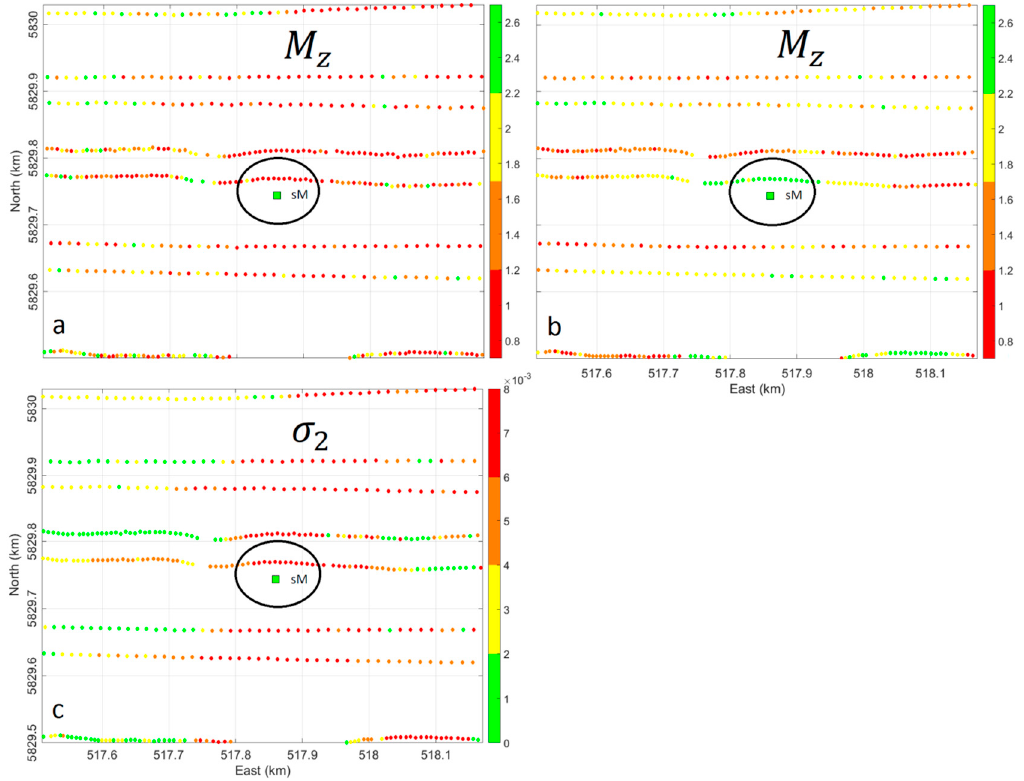
Figure 12. Zoom-in map of inverted geoacoustic parameters using optimization method applied to mean backscatter curve around grab sample 23 (indicated inside ellipses with green square and 𝑀 (cid:3053) = 4.40 (cid:3399) 1.40 ); ( a ) mean grain size 𝑀 (cid:3053) for which search was performed only over 𝑀 (cid:3053) (fixing 𝑤 (cid:2870) and 𝜎 (cid:2870) ), ( b ) mean grain size 𝑀 (cid:3053) , and ( c ) volume scattering parameters 𝜎 (cid:2870) for which search was performed over three parameters 𝑀 (cid:3053) , 𝑤 (cid:2870) , and 𝜎 (cid:2870) .